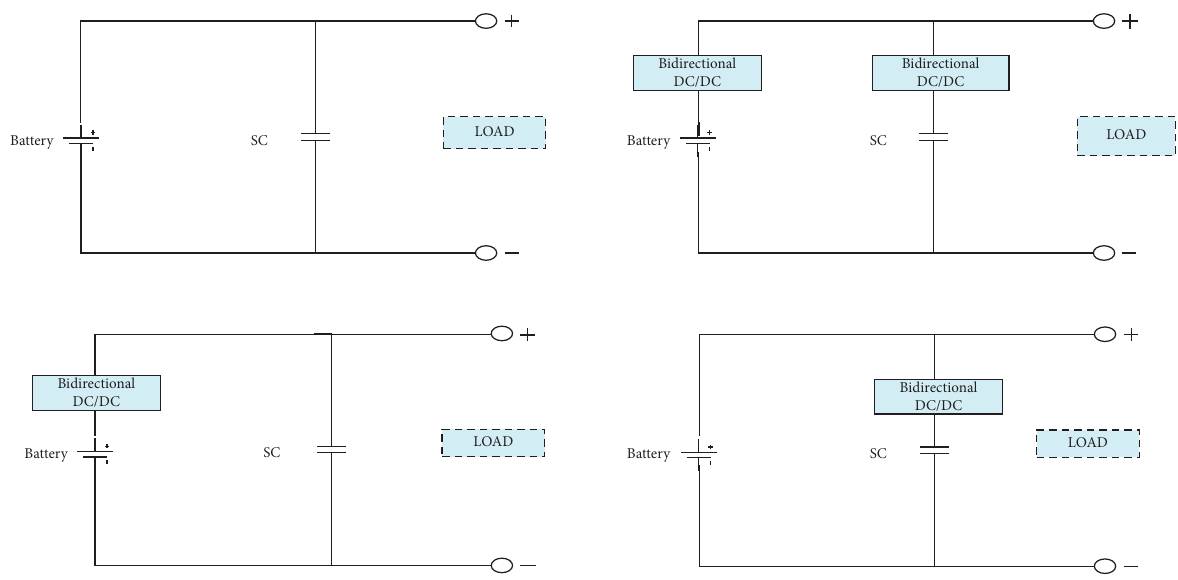
Figure 14: Widely used HESS topology structure [153].